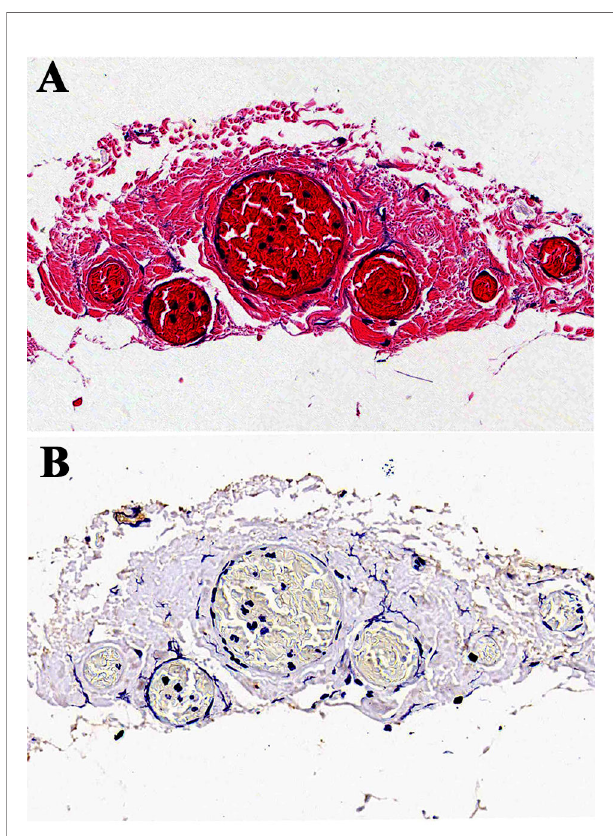
FIGURE 3 | H&E and immunohistochemical staining (S100) of extra-nerve plane station 253 nodes. (A) H&E staining of extra-nerve plane station 253 nodes. (B) Immunohistochemical staining of extra-nerve plane station 253 nodes with anti-S100 antibodies. Abundant nerve fi bers positively stained for S100 were deep brown and observed in extra-nerve plane station 253